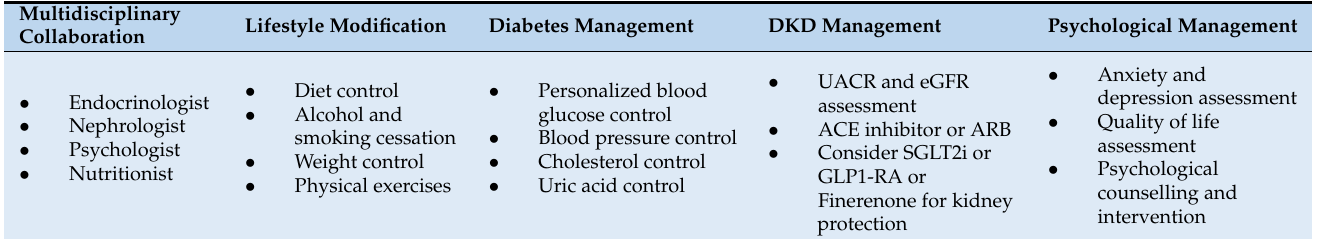
Table 7. Comprehensive strategies for the management of patients with type 2 diabetes and